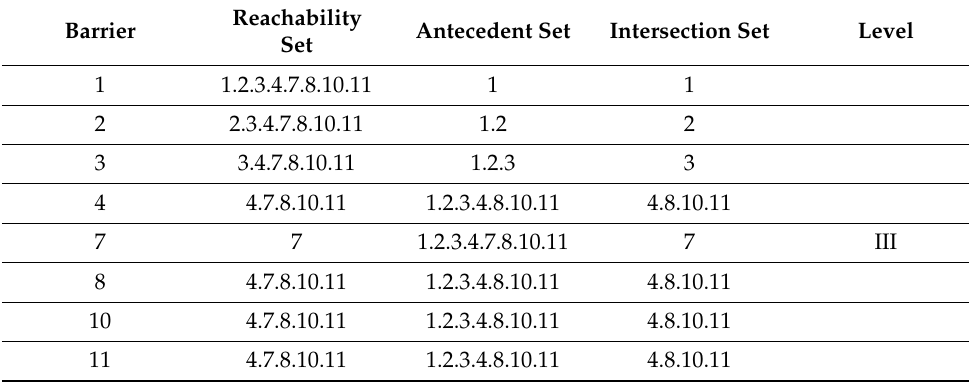
Table A6. Level Partitioning—3rd Iteration.